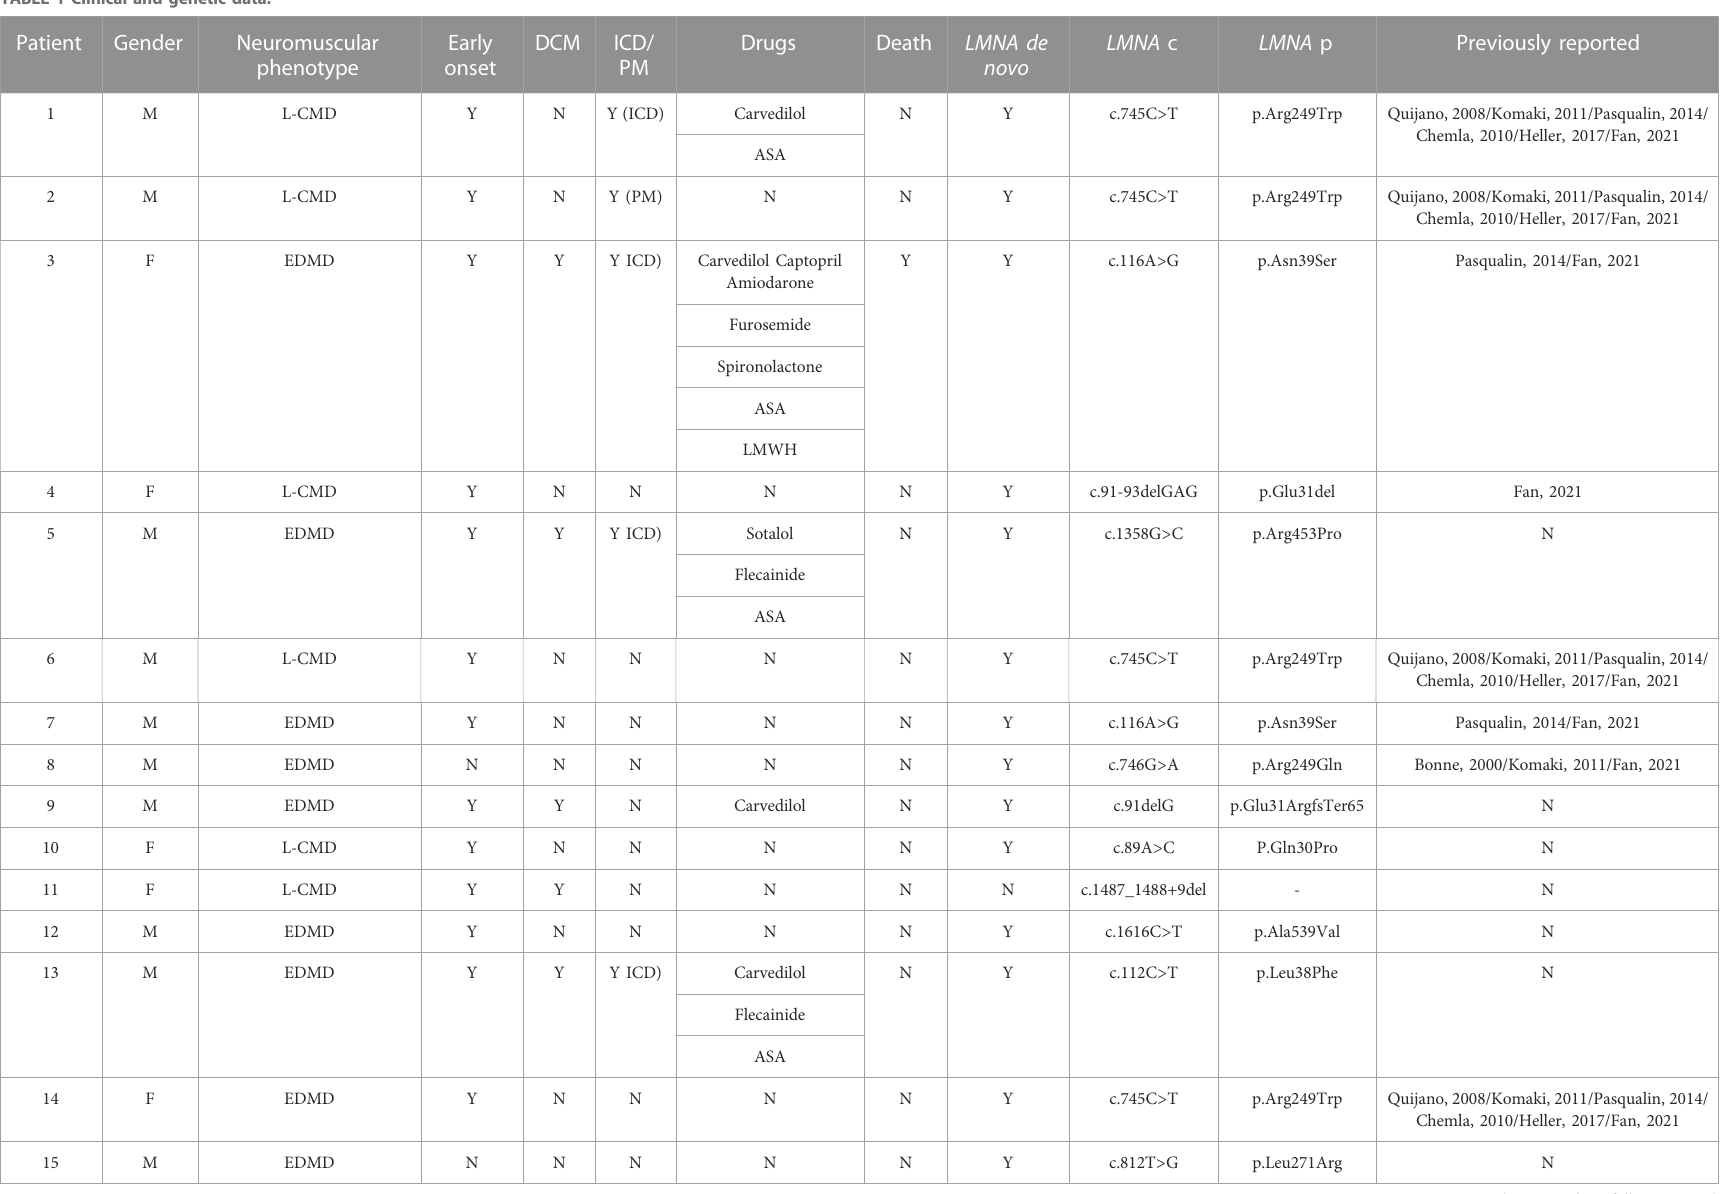
TABLE 1 Clinical and genetic